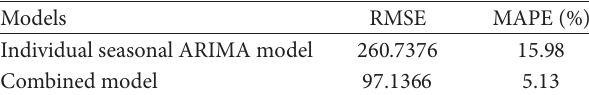
Table 2: Comparison of RMSE and MAPE.